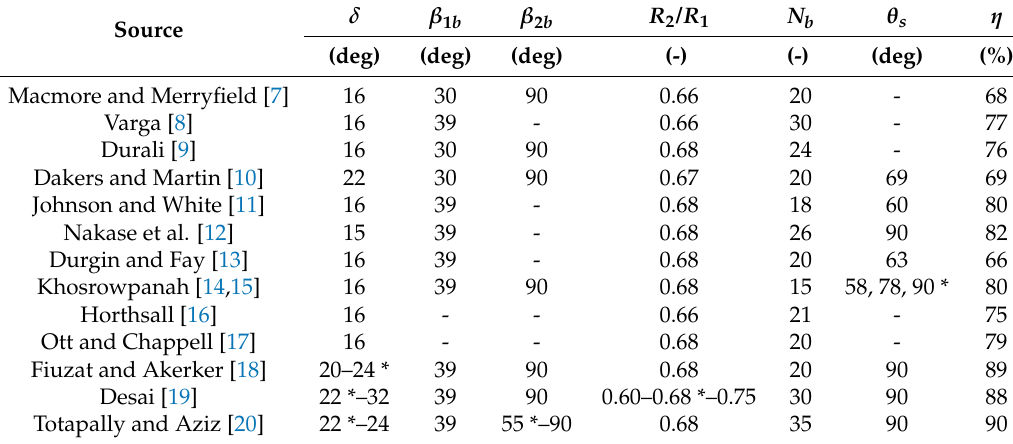
Table 1. Summary of the design parameters used in the experimental studies. * indicates a value for maximum efficiency. Symbols are defined in Figure